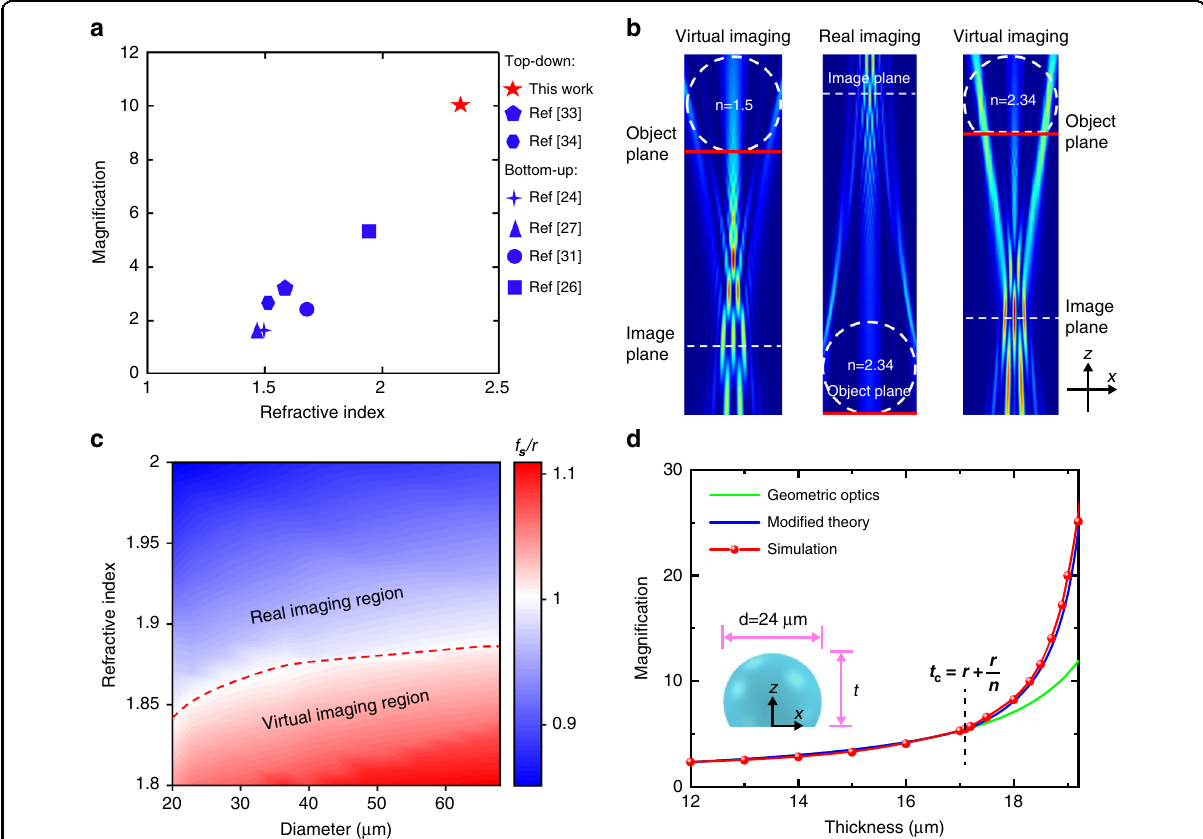
Fig. 1 The design and imaging characteristics of HHMSs. a Comparisons of magni fi cation and refractive index of PSMLs in literatures and this work. b Simulated imaging of n = 1.5 microsphere (left, virtual), n = 2.34 microsphere (middle, real) and n = 2.34 HHMS (right, virtual), respectively. Object planes (red lines), image planes (white dashed lines) and microsphere outlines (white dashed circles) are highlighted in the fi gure. c Relative focal length ( f s /r) of microsphere at different refractive indices and microsphere diameters. d Magni fi cation versus HHMS thickness t . The green, blue and red plots represent calculation results based on geometric optics theory, modi fi ed theory, and simulation results,